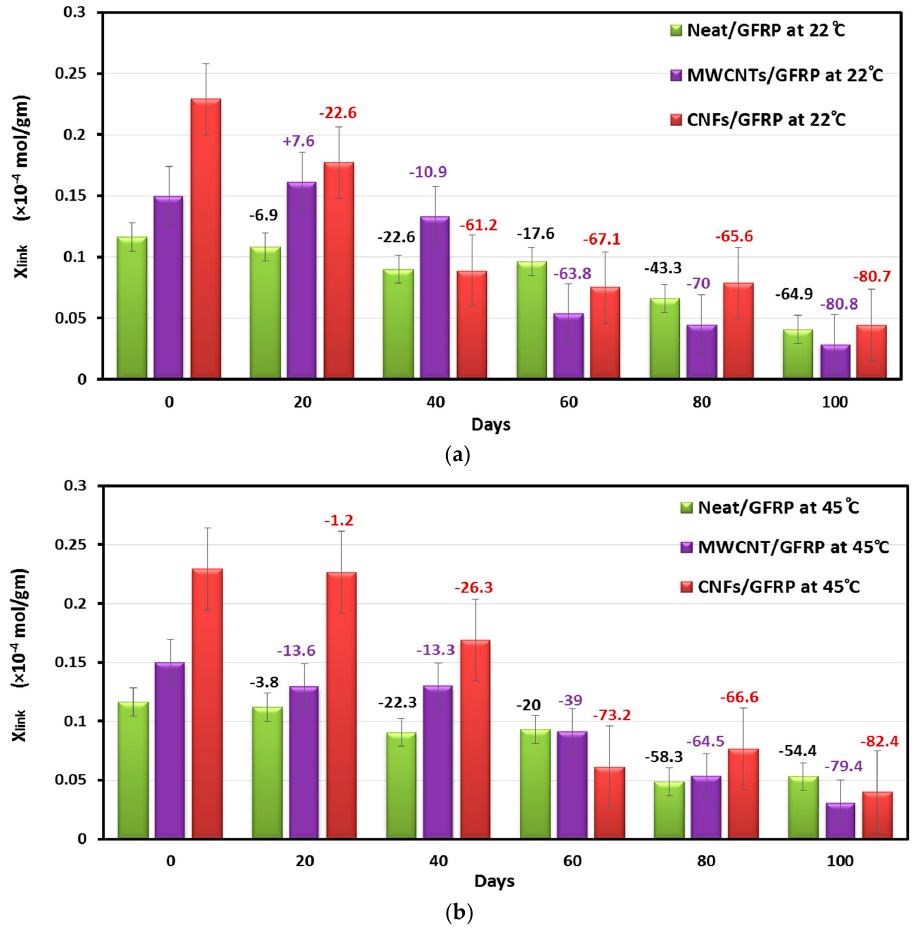
Figure 11. The degree of crosslinking for Neat/GFRP, MWCNTs/GFRP and CNFs/GFRP composites vs. immersion time at temperatures ( a ) 22 °C and ( b ) 45 °C.